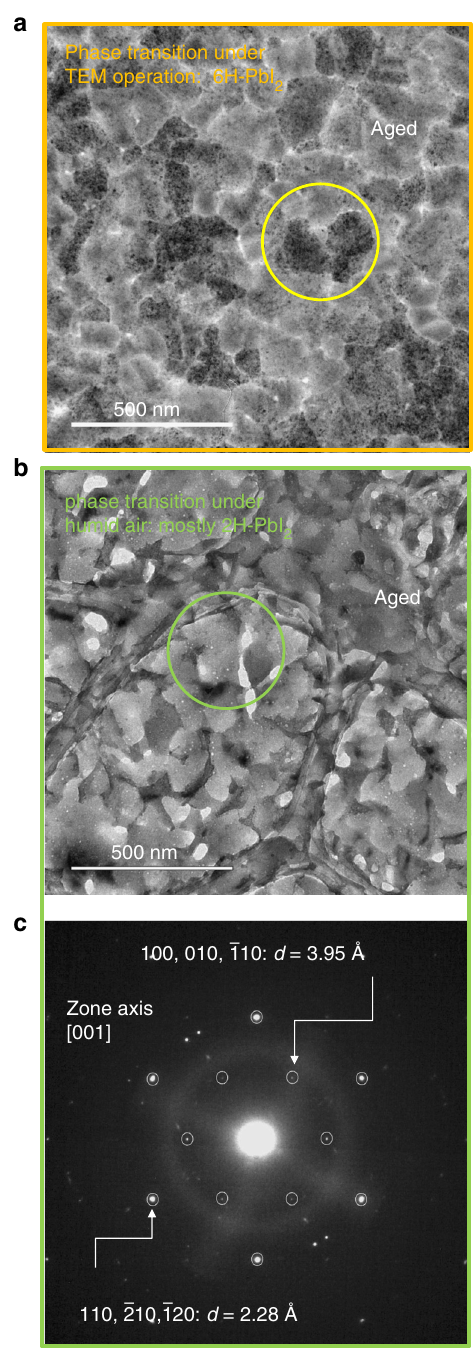
Fig. 6a we further draw that inclusions of 6H-PbI 2 can be formed, as testi fi ed by the small peak detected at 2 θ = 28.23° ((104)-type planes, see fi gure 4c). This peak is not present in the 2H-PbI 2 pattern (see simulations in Fig. 6e). In some other MAPbI 3 samples, less statistically encountered, a predominance of the 6H polytype over the 2H can be found as shown in Fig. 6c. This countertrend is represented by the major relative intensity of the (104) peak of the 6H-PbI 2 over the (002) peak of the 2H polymorphism. This degradation path was called B. It is interesting to notice the unusual shape of this diagnostic peak centred at 2 θ = 28.23°: it is broad at the basis as expected for a